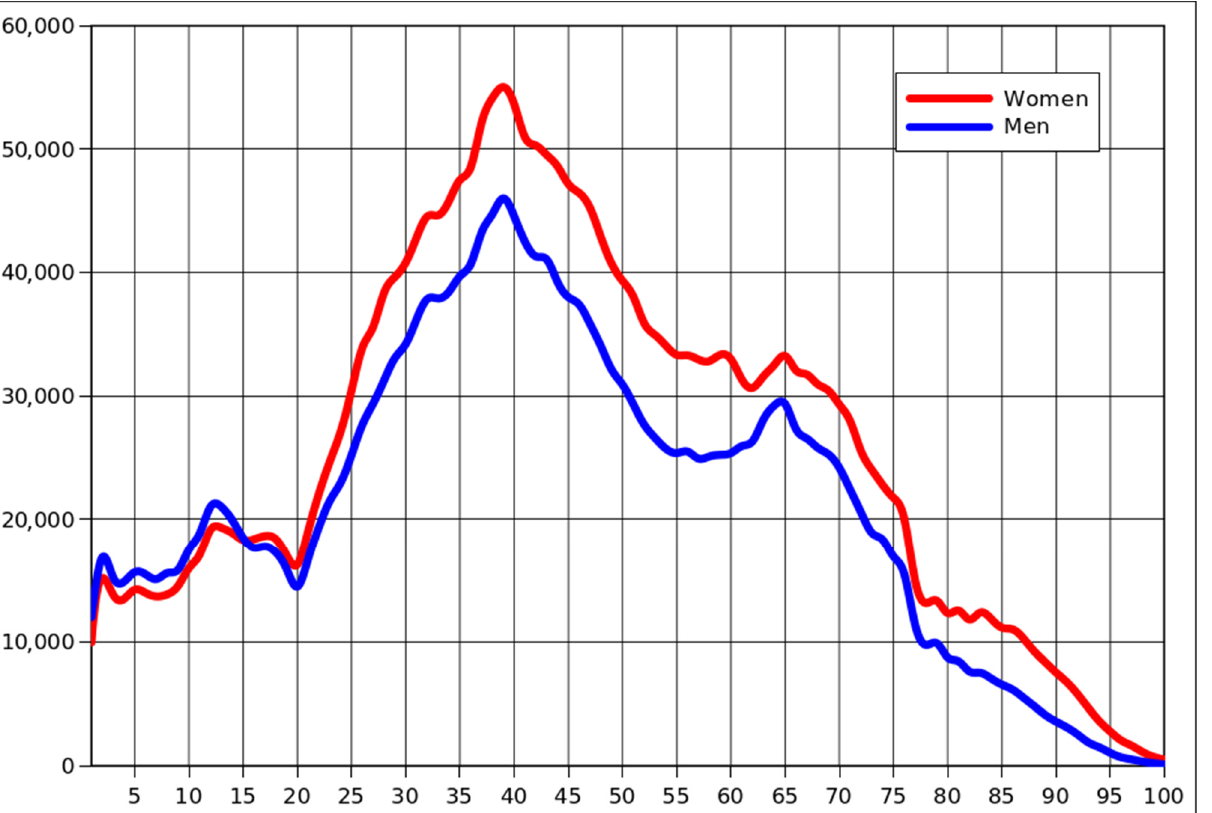
Figure 2. The number of cases in each yearly cohort that was diagnosed with COVID-19, by gender, for the period 1 January 2021 to 21 March 2022.